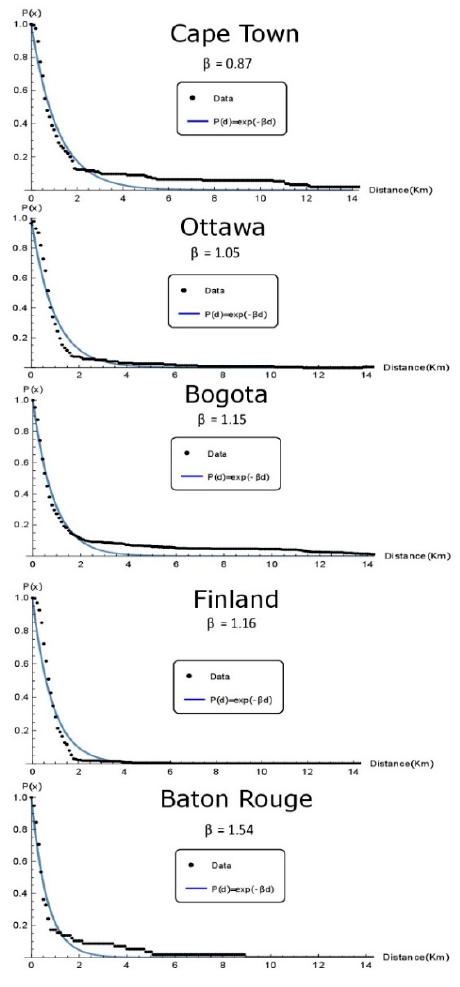
Figure 2. Distance decay curves by study site.